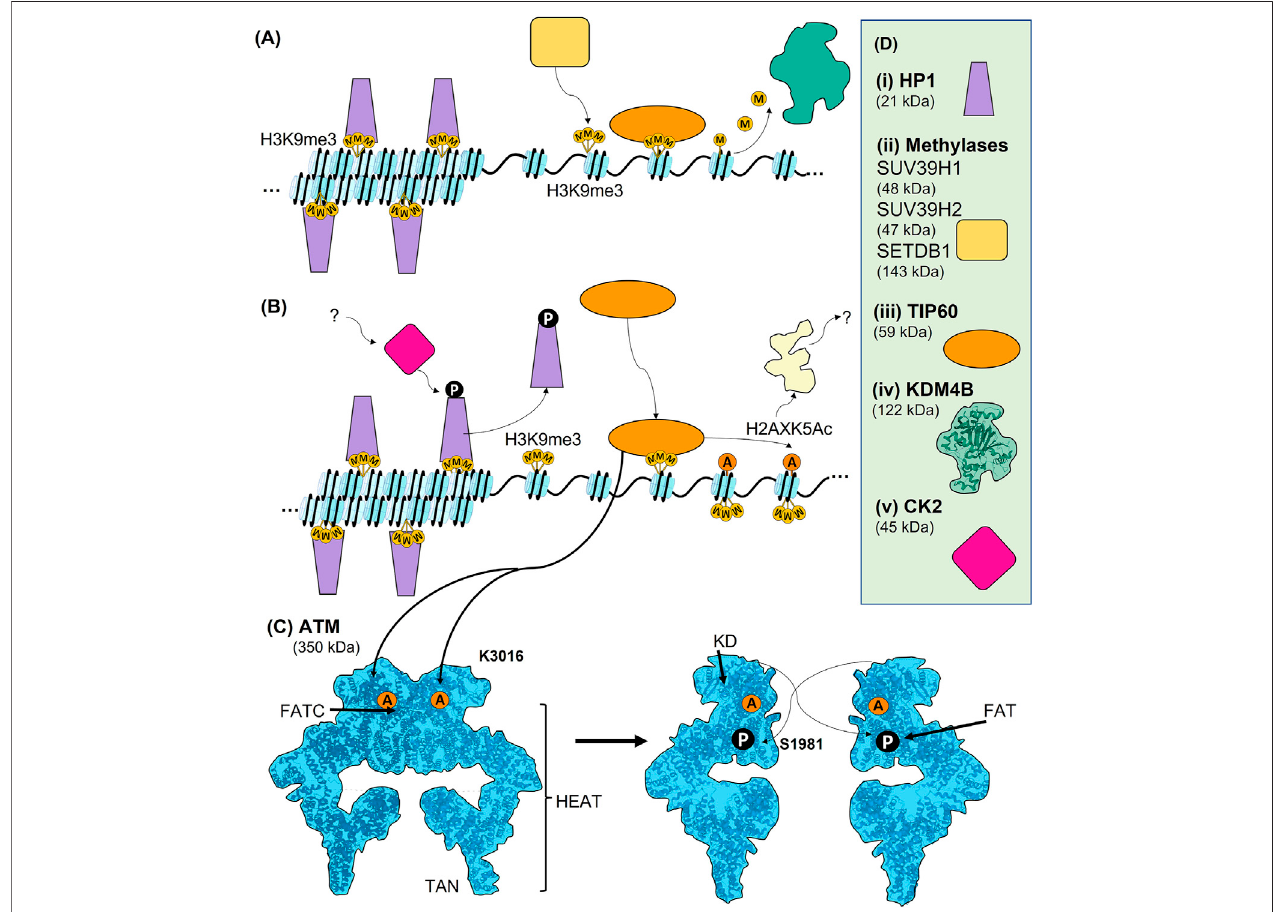
FIGURE3| Earlychromatin eventsleadingtothe activationofATM. (A) ThecompactionofchromatinpriortoDNAdamageinvolves trimethylationofhistoneH9at lysine 9 (H3K9me3). In heterochromatin, HP1 binds to H3K9me3 and contributes to chromatin condensation. Although a largely heterochromatic mark, H3K9me3 is also present in euchromatin, where it contributes to transcriptional regulation, and is therefore tightly regulated. It can be methylated by SUV39H1, SUV39H2, and SETDB1, and demethylated by KDM4B. When free of other binding proteins H3K9me3 can bound by TIP60 in its role as a regulator of transcription. (B) The regulation of H3K9me3 upon DNA damage and the activation of TIP60. In heterochromatin, CK2-dependent phosphorylation of HP1 (T51) causes its release from H3K9me3, leading to chromatin decondensation. Free H3K9me3 can then be bound by TIP60. When TIP60 is bound it can acetylate lysine 5 of histone H2AX (H2AXK5Ac), leadingtofurther chromatin decondensation.H2AXK5Ac canalso contribute toPARP-dependentPARylation aroundDSBs. (C) Activation ofATMoccurs via TIP60-dependent acetylation of K3016 within the FATC domain of ATM. ATM is present as a largely inactive dimer prior to damage, and this acetylation causes it to monomerise. Autophosphorylation of S1981 within the FAT domain of ATM also likely contributes to activation of ATM. In addition to the FATC and FAT domain, ATM alsoiscomprisedofakinasedomain(KD)andHEATrepeats.BoththeFATandTANdomainarespecialisedHEATrepeats. (D) Whereknown,structureissuperimposed within overall architecture as illustrated. (i) Schematic of HP1. (ii) General schematic of H3K9 methylases, including SUV39H1, SUV39H2, and SETDB1. (iii) TIP60 schematic. (iv) CK2